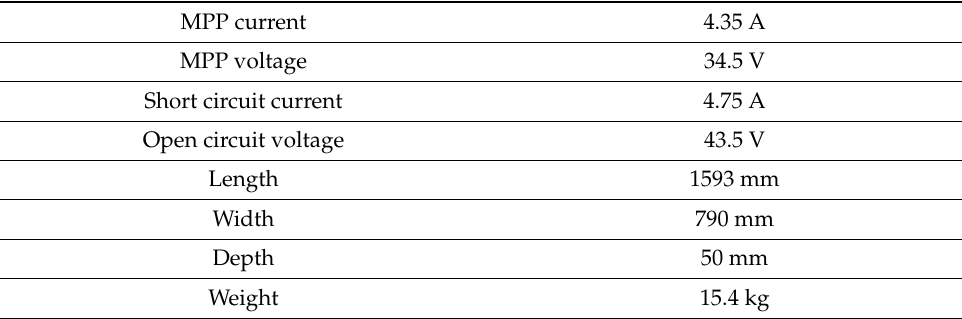
Table 1. PV module specifications utilized